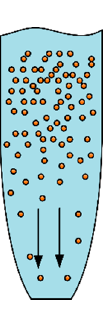
Figure 4. Schematic diagram of copper ion depletion near the edge of the nozzle.